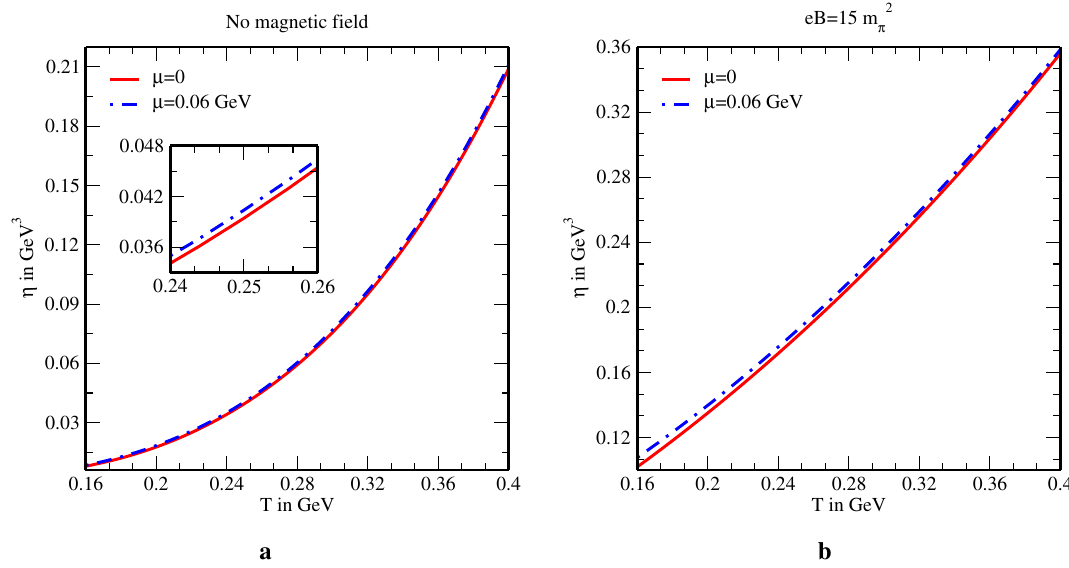
Fig. 3 Variations of the shear viscosity with temperature in the a absence and b presence of strong magnetic field